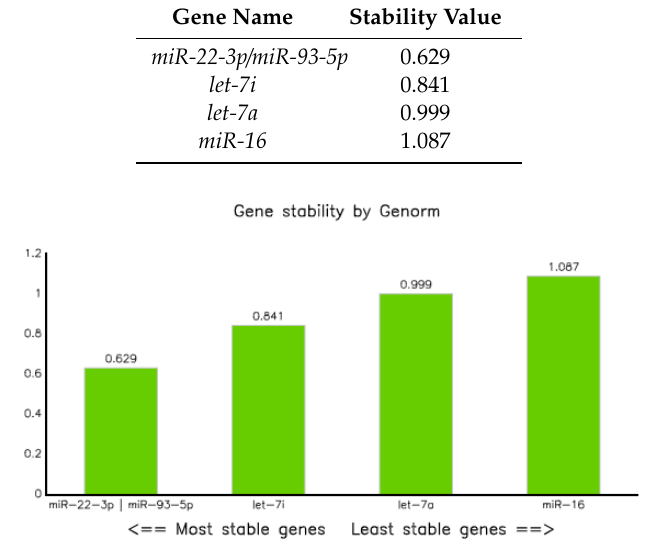
Table 7. Stability of endogenous miRNA calculated using the GeNorm application. MiR-22-3p and